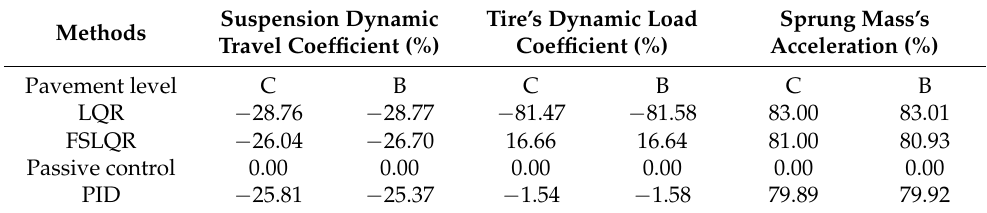
Table 4. The improvement degree of different parameters ’ response performance under random excitation.